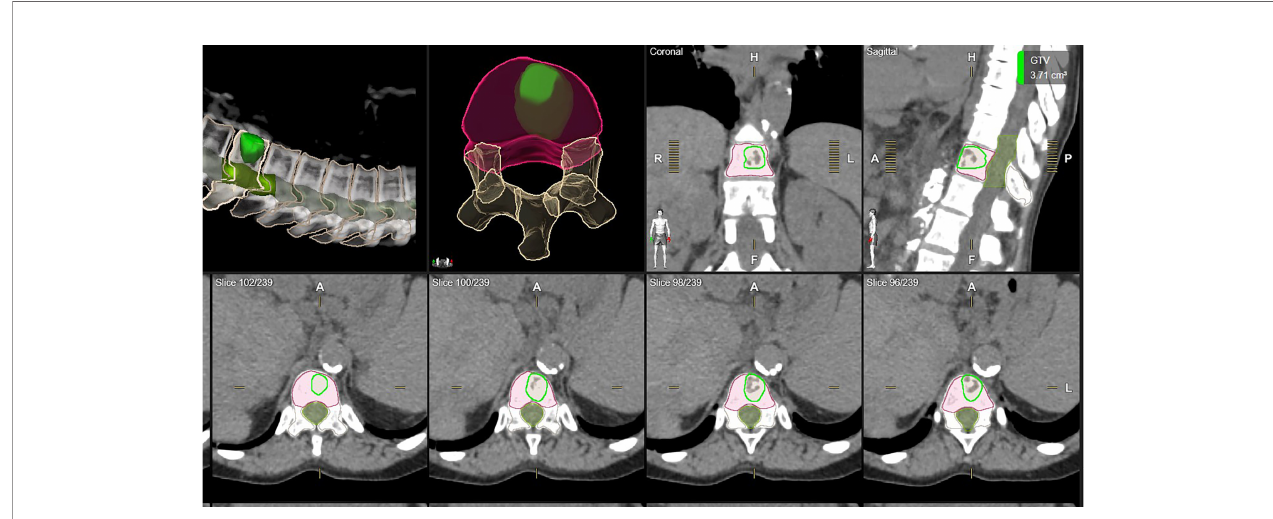
FIGURE 1 | One example of auto-segmented CTV. All vertebrae were segmented and the auto-segmented CTV was automatically generated by ESS following ISRC consensus guidelines. Green: clinically used GTV. Orange: clinically used CTV. Red: ESS-generated CTV, labeled as Clinical Target in